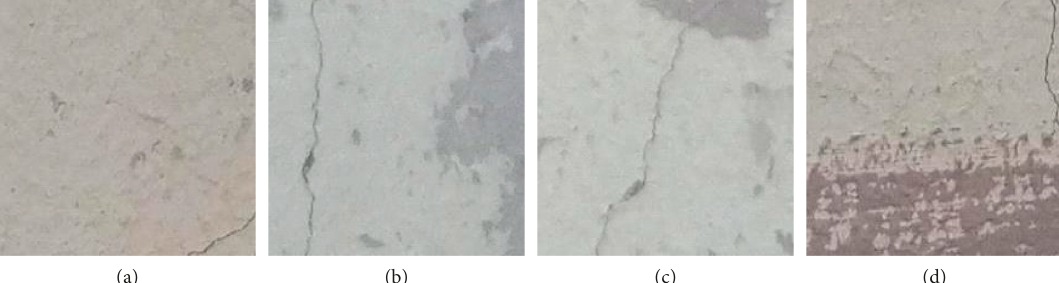
Figure 1: Sample cracks. (a) Short cracks at edges. (b) Central cracks. (c) Short cracks at corners. (d) Long cracks at